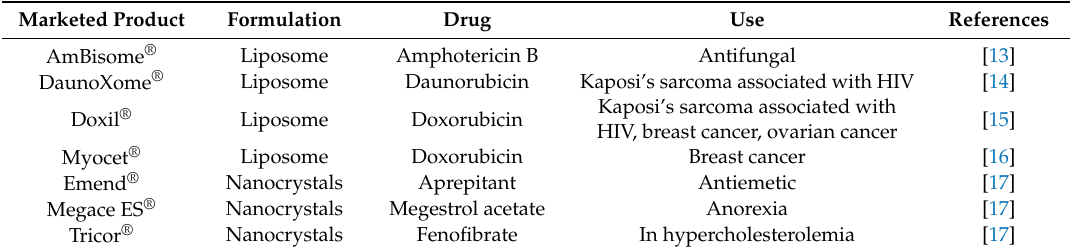
Table 1. List of some marketed products containing